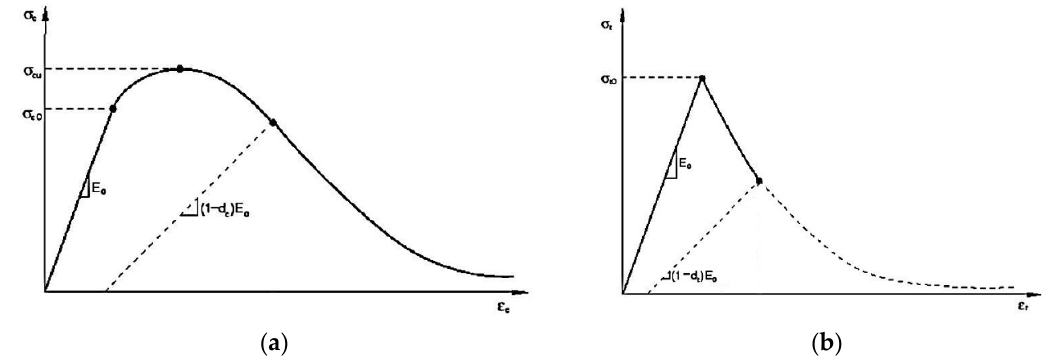
Figure 5. Behavior of the concrete to uniaxial loading: ( a ) compression; ( b ) tension.